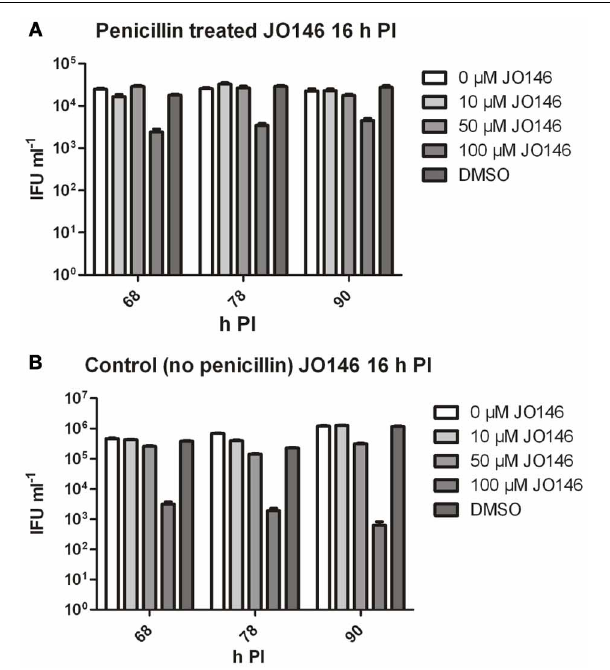
FIGURE 4 | Viable infectious yield of C. trachomatis after treatment with JO146 during penicillin persistence. The figure shows viable IFU ml − 1 from each culture condition at several time points after reversion was commenced (penicillin removal at 30h PI). Cultures were treated with penicillin 100U ml − 1 at 4h PI, and with JO146 at 16h PI (concentrations indicated by the gray shading, see key to the right of each graph). Penicillin was removed from the cultures at 30h PI. (A) Viable infectious yield from penicillin treated and restored cultures. (B) Viable infectious yield from control cultures which did not have penicillin added. Statistics were conducted using Two-Way